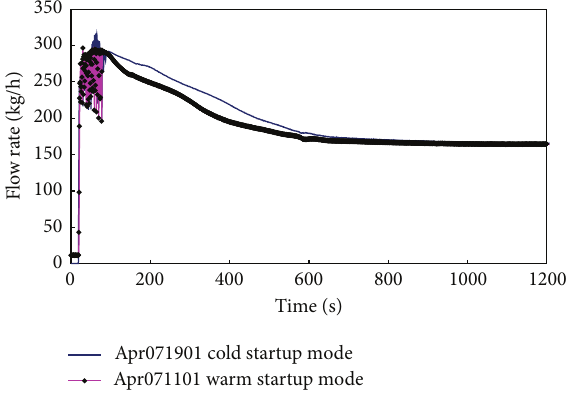
Figure 4: The natural circulation flow rate.